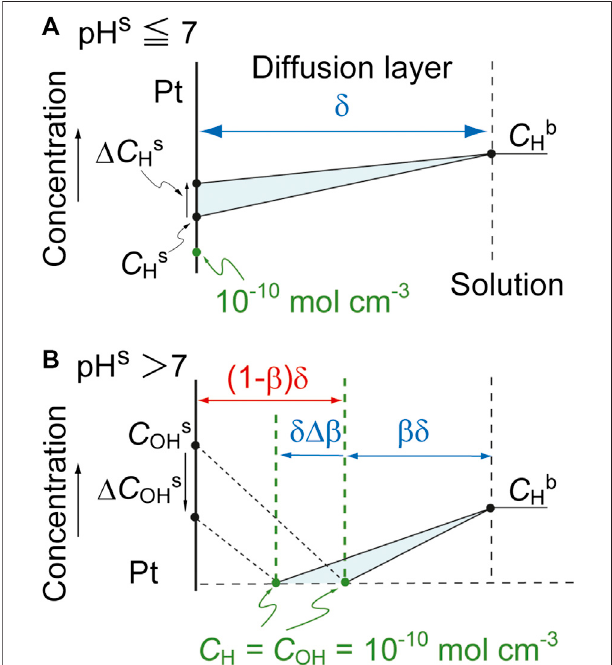
FIGURE 5 | Changes in the near-surface concentration pro fi les for (A) pH s ≤ 7 and (B) pH s > 7. Here, Δ C s is a small change in C s over a brief time interval, Δ t , and Δ C Hs is assumed to be